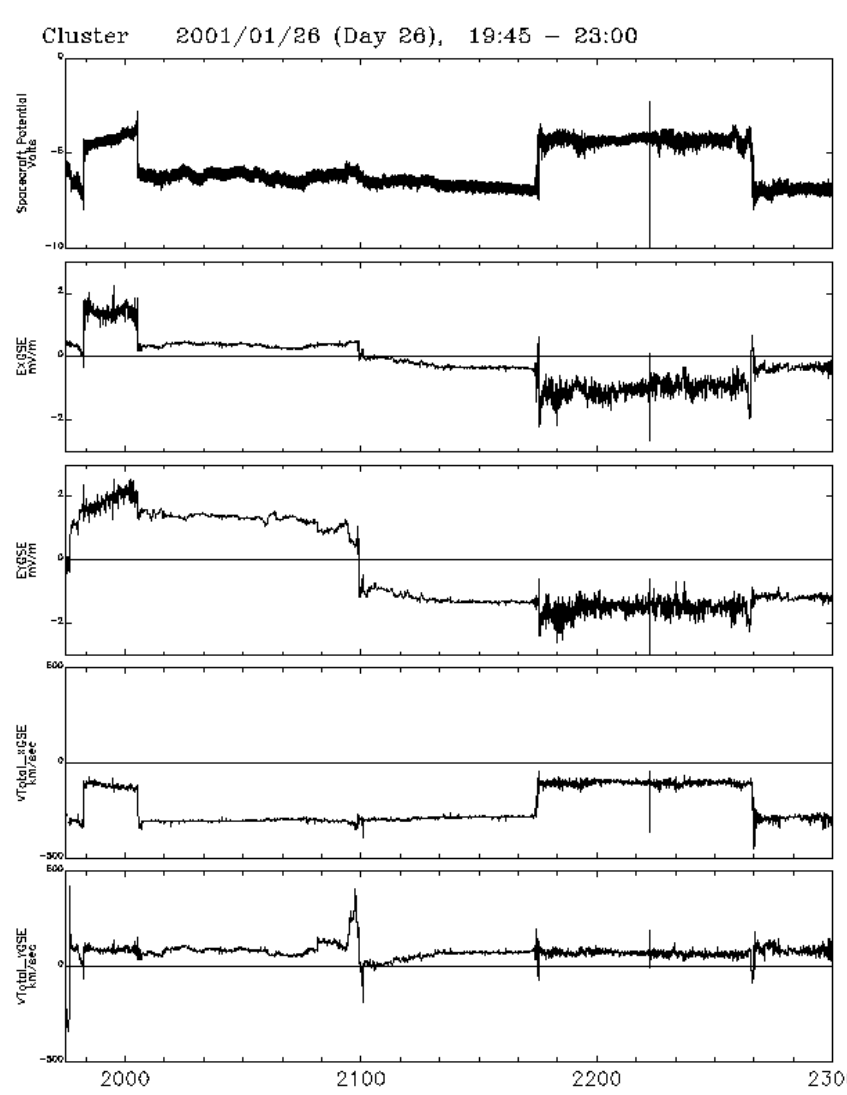
Fig. 16. Example of flow velocities for a period of more than three hours, during which the Cluster spacecraft were in the magnetosheath and solar